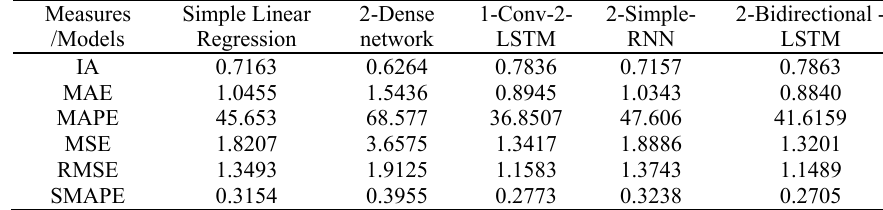
Table 5. Performance evaluation measures for different models on Madurai station